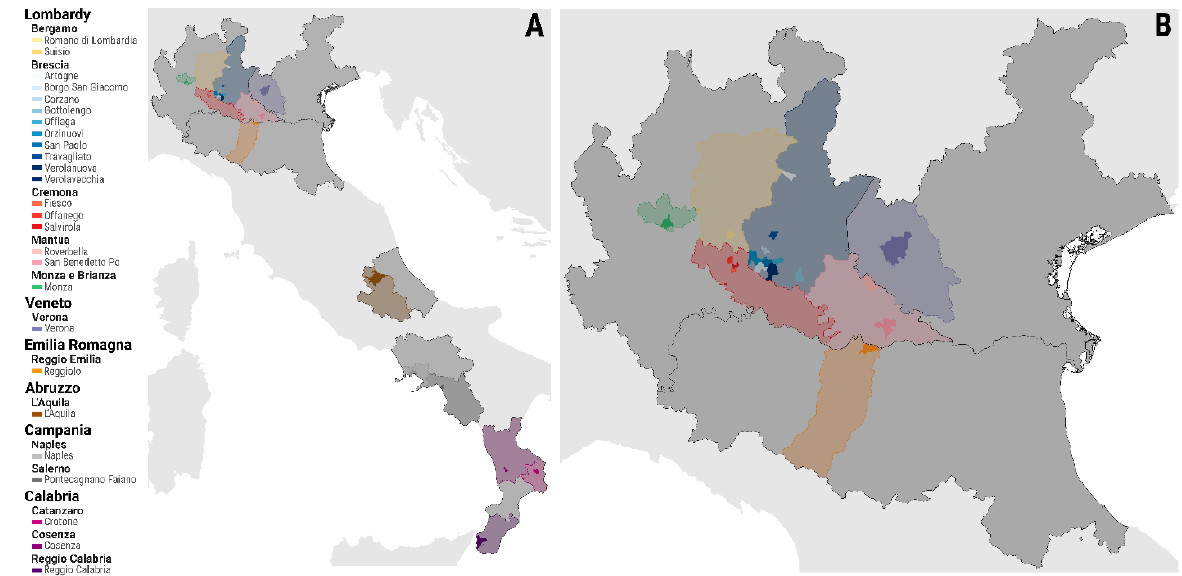
Figure 1. Geographical distribution of the Italian municipalities affected by the 2006–2007 SVD epidemic investigated in this study. Full geographical extent of the epidemic event including the southern Italian cluster ( A ) and the northern epidemic cluster only ( B ). Geographical locations are presented as region (first admin-level), province (second admin-level), and municipalities (third admin-level).